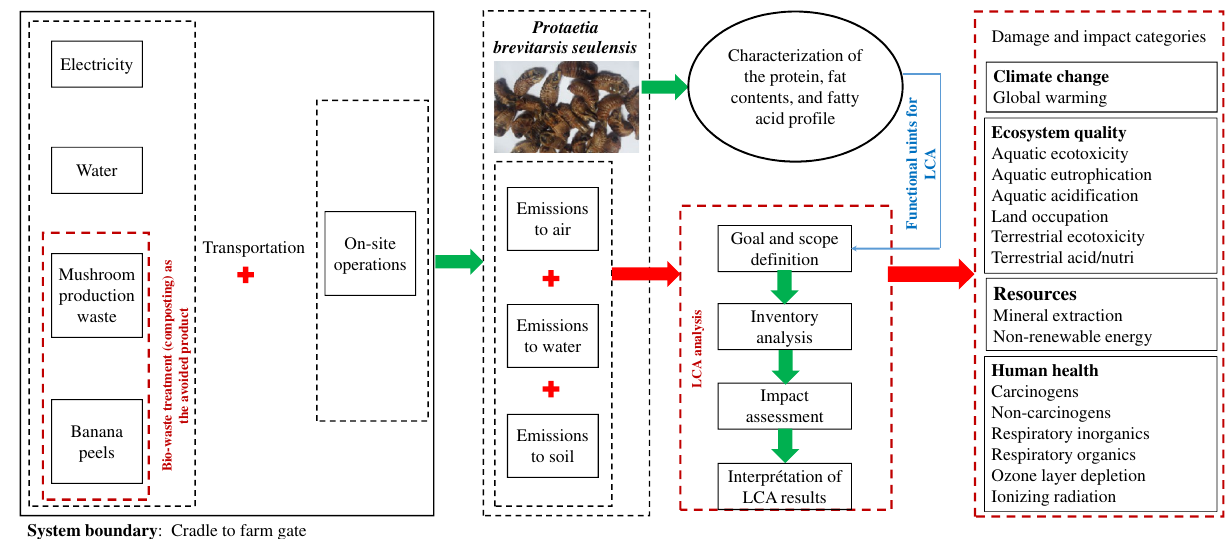
Figure 4. Life cycle assessment procedure of Protaetia brevitarsis seulensis